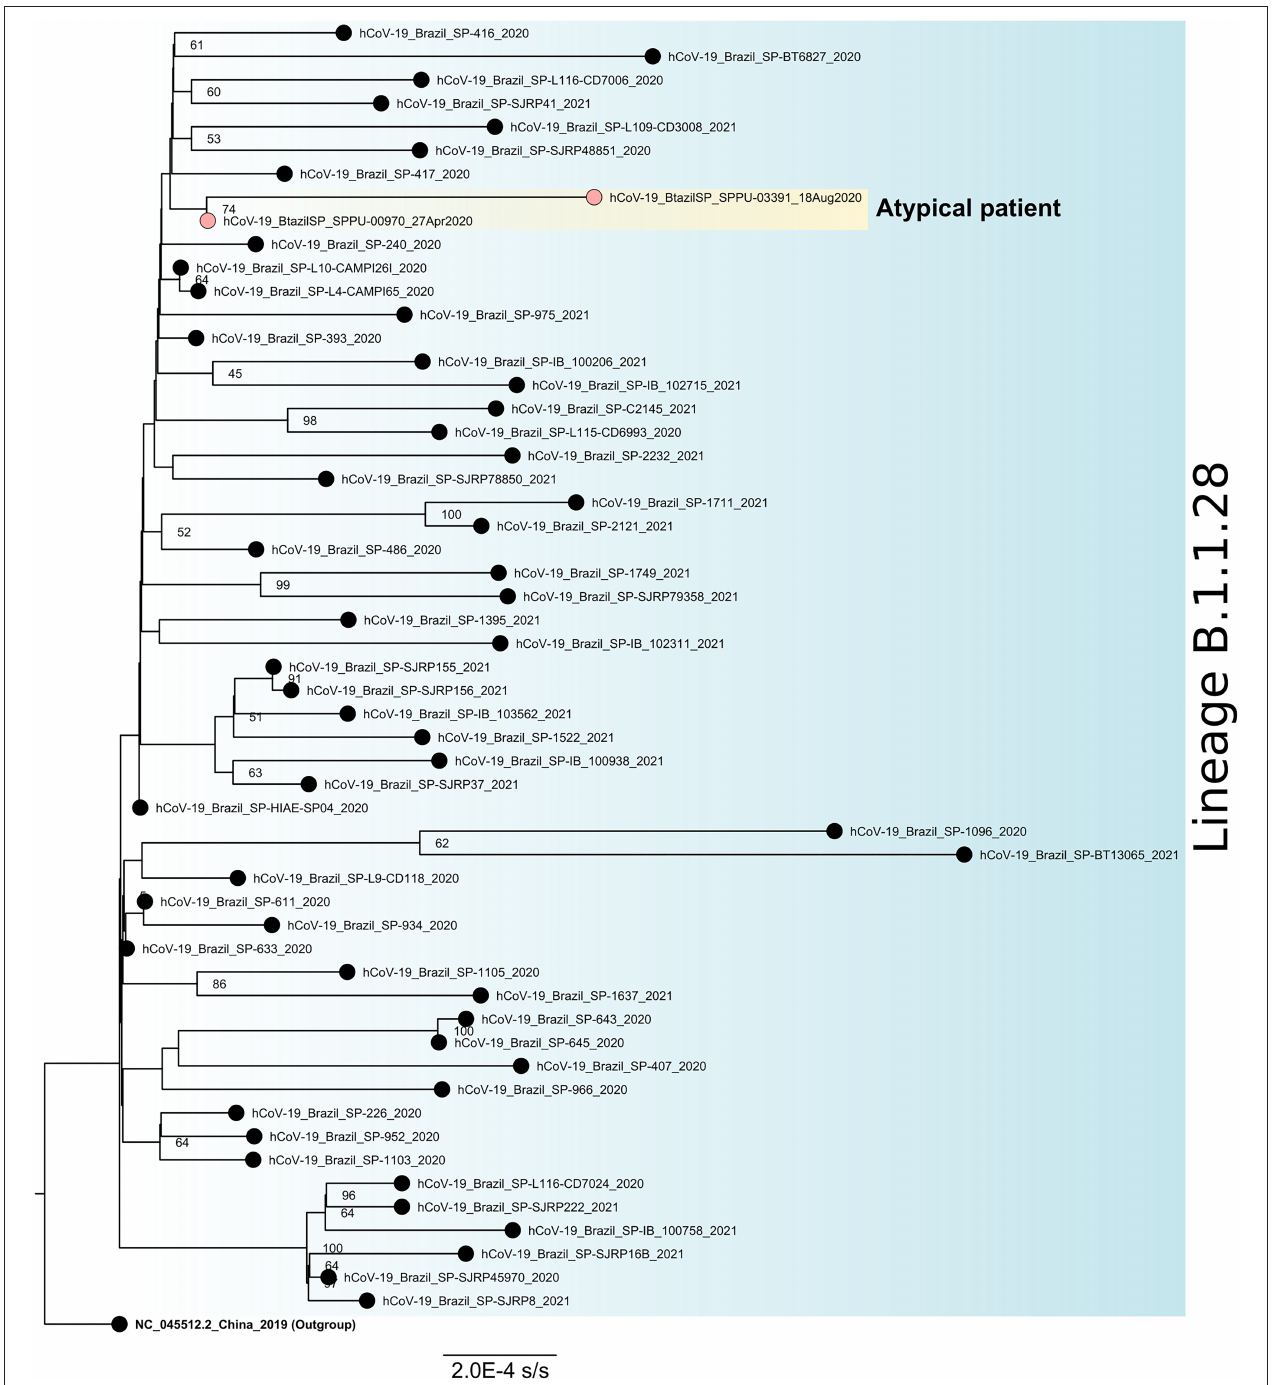
FIGURE 4 | Maximum likelihood phylogenetic tree for SARS-CoV-2 lineage B.1.1.28 based on full-length genome sequences ( n = 56). The sequence NC_045512.2 was used as an outgroup to reroot the tree and the nodes are labeled with bootstrap support values higher than 50. The two sequences obtained from the atypical patient are highlighted in yellow. SARS-CoV-2, severe acute respiratory syndrome coronavirus 2.